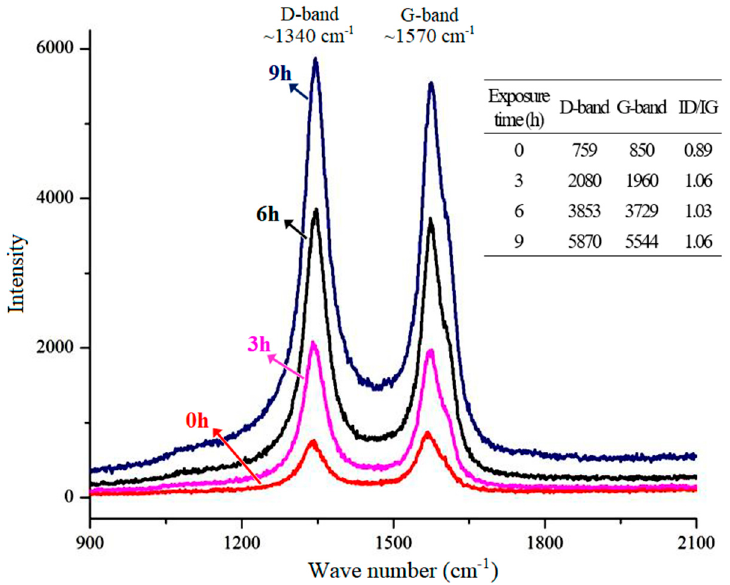
Figure 2. Raman spectra of the CNT with different exposure times to H 2 SO 4 /HNO 3 solution.